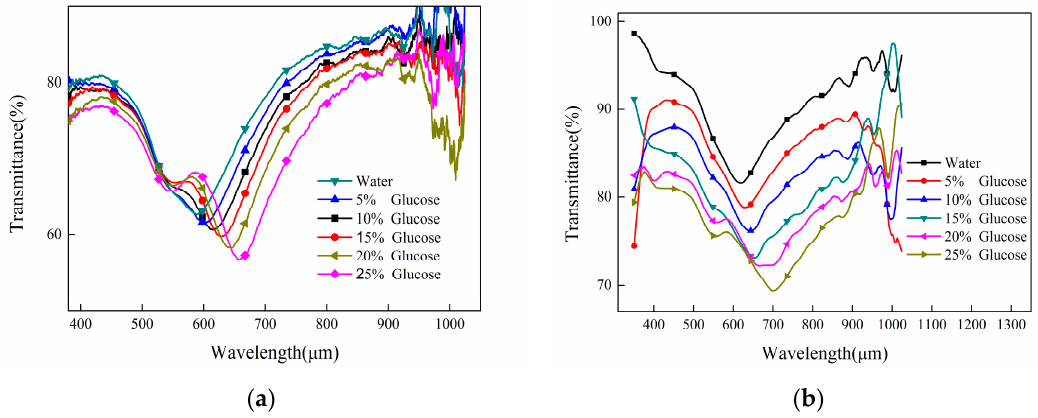
Figure 9. Comparison of experimental transmittance. ( a ) The gold film was not coated with graphene; ( b ) The gold film is coated with graphene.